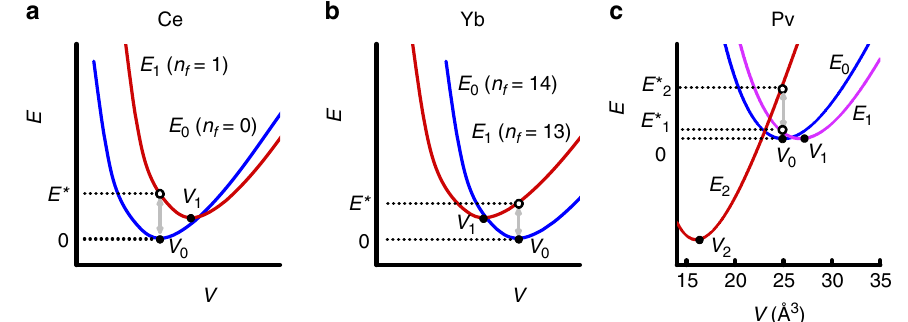
Fig. 2 Schematic volume-dependent energies of different electronic con fi gurations. a Schematic volume V -dependent energies E for two con fi gurations of Ce and its compounds, in which E 0 (blue line) has n f = 0 4 f -electrons con fi ned to the atomic core and E 1 (red line) has n f = 1 4 f -electron con fi ned to the core. Following Wohlleben 28 and Wittershagen and Wohlleben 60 we have adopted the convention whereby E 1 > E 0 at V = V 0 corresponds to E * > 0 and E E V = V E * < 0. b A similar schematic for Yb. c A possible scheme for δ -Pu that is consistent with x -dependent fi ts to 1 < 0 at 0 corresponds to a magnetostriction and thermal expansion, consisting of three volume-dependent con fi gurational energies E 0 (blue line), E 1 (violet line) and E 2 (red line) and two excitation energies E (cid:1) and E (cid:1) (indicated using dotted lines; see Methods). The number of 5 f -electrons con fi ned to the atomic core in each case remains 1 2 to be